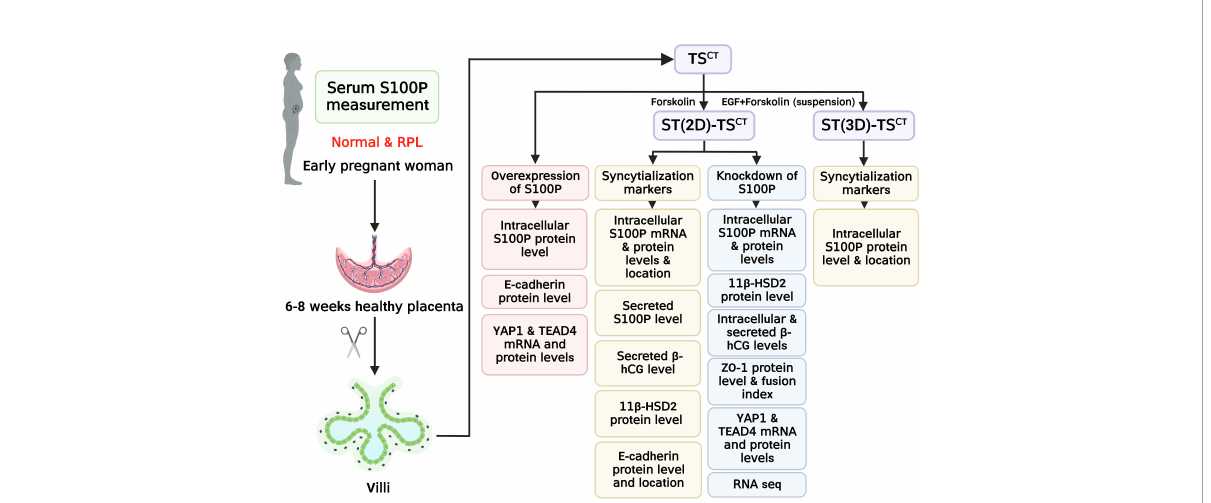
FIGURE 1 Flowchart of the experimental design. Healthy controls and patients with RPL were chosen based on the inclusion criteria. Villi and serum samples from participants were collected to measure tissue and serum S100P levels, respectively. Human TS CT cells were isolated and cultured from human villous cytotrophoblasts. ST(2D)-TS CT and ST(3D)-TS CT cells were used to investigate intracellular S100P expression and location, whereas ST(2D)-TS CT cells were used to detect 11 b -HSD2 protein levels, E-cadherin expression and localization, and secreted S100P and b -hCG levels in the culture medium. After knocking down S100P in ST(2D)-TS CT cells, intracellular S100P mRNA and protein levels, 11 b -HSD2 protein levels, intracellular and secreted b -hCG levels, ZO-1 expression and localization, the fusion index, YAP1 and TEAD4 mRNA and protein levels, and RNA-seq were detected. After overexpressing S100P in TS CT cells, intracellular S100P and E-cadherin protein levels, and YAP1 and TEAD4 mRNA and protein levels were